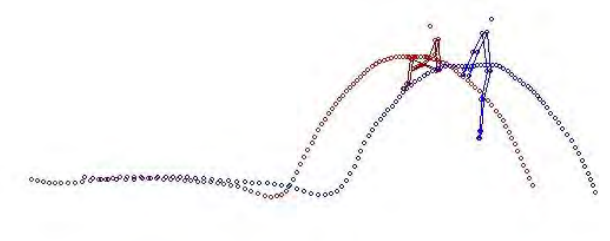
Fig.5. Phase of main movements at acrobats’ passing to second somersault (grouped back double somersault after rondat and arched back double somersault after rondat – back turnover. Key element of sport technique – MP ―grouping ‖ (tested A, variant 1, time 1. 266 sec.) and MP ―arching ‖ (tested B, variant 2, time 1. 183 sec.).